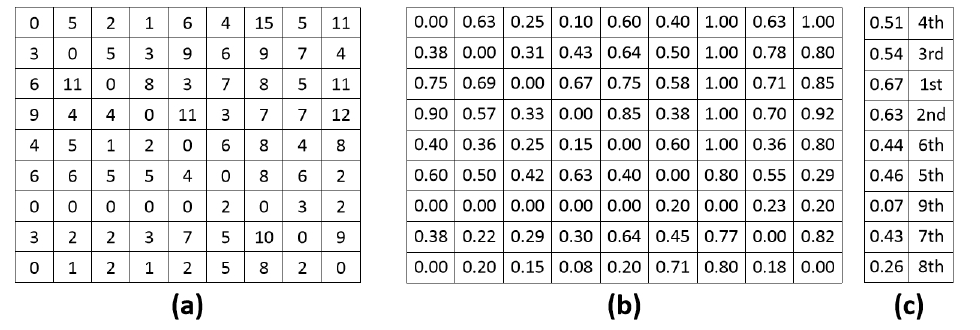
Figure 14. Process of pair comparison matrix analysis: ( a ) The pair comparison matrix of an HDR scene in which PCM [ i , j ] is the number of times I i is preferred when comparing I i to I j , ( b ) Bradley– Terry score Matrix of each HDR scene, ( c ) IQ and ranks of tone-mapped versions of each HDR